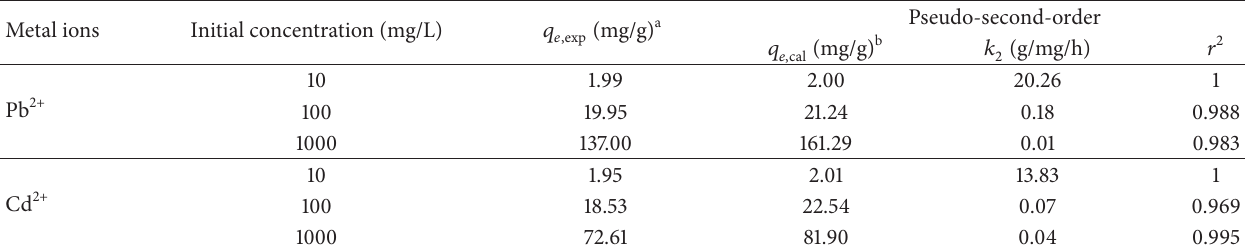
Table 7: Pseudo-second-order kinetic parameters for adsorption of Pb 2+ and Cd 2+ on 20/80 HAp/chitosan hybrid fiber. Metal